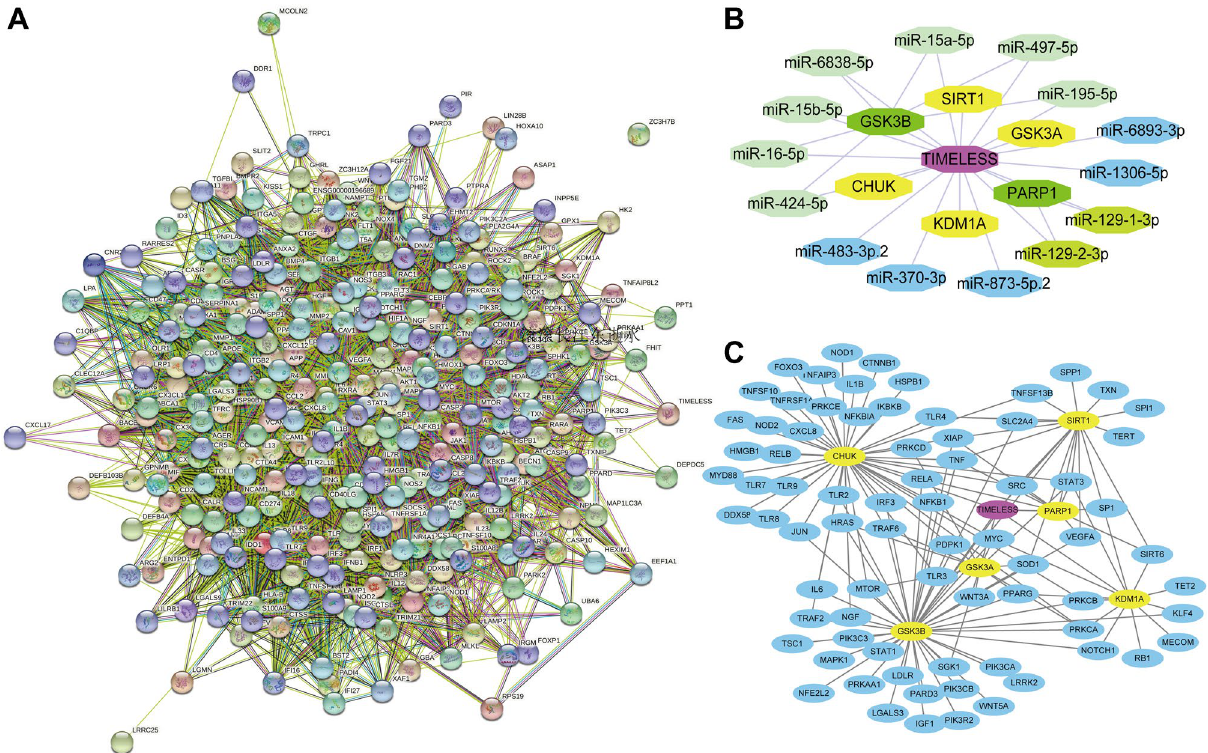
Figure 10. Analysis of the correlation of TIMELESS, autophagy genes and miRNA. ( A ) Protein–protein interaction (PPI) networks for TIMELESS and autophagy related genes. 319 candidate genes from monocytes which were responsible for autophagy were obtained from the “gene” module of NCBI website. ( B ) Identification of the target miRNA of TIMELESS and autophagy genes. 14 conserved miRNAs of TIMELESS were obtained from Targetscan. Blue colored nodes represent miRNAs that only interact with TIMELESS. Yellow colored nodes represent autophagy genes that only interact with TIMELESS. Green colored nodes represent the interacting autophagy genes and miRNAs. ( C ) PPI networks for TIMELESS associated genes and autophagy genes. Blue colored nodes are the genes derived from Figure A, which are directly associated with SIRT1, GSK3A, GSK3B, PARP1, CHUK and